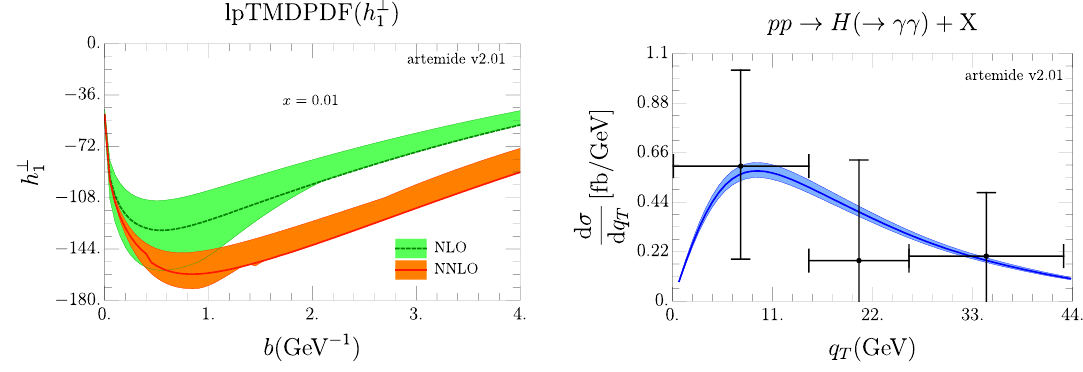
Figure 2 . (left) The lpTMDPDF, eq. (2.15){(2.16), as a function of b at x = 0 : 01. The shaded area shows the variation band in ~ (cid:22) , see eq. (3.18). (right) Comparison of Higgs-production cross-section with variation band to the measurement presented in [69] by CMS